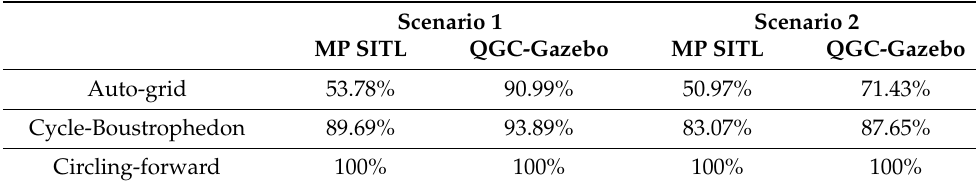
Table 4. Comparison of the coverage rate between different methods on different